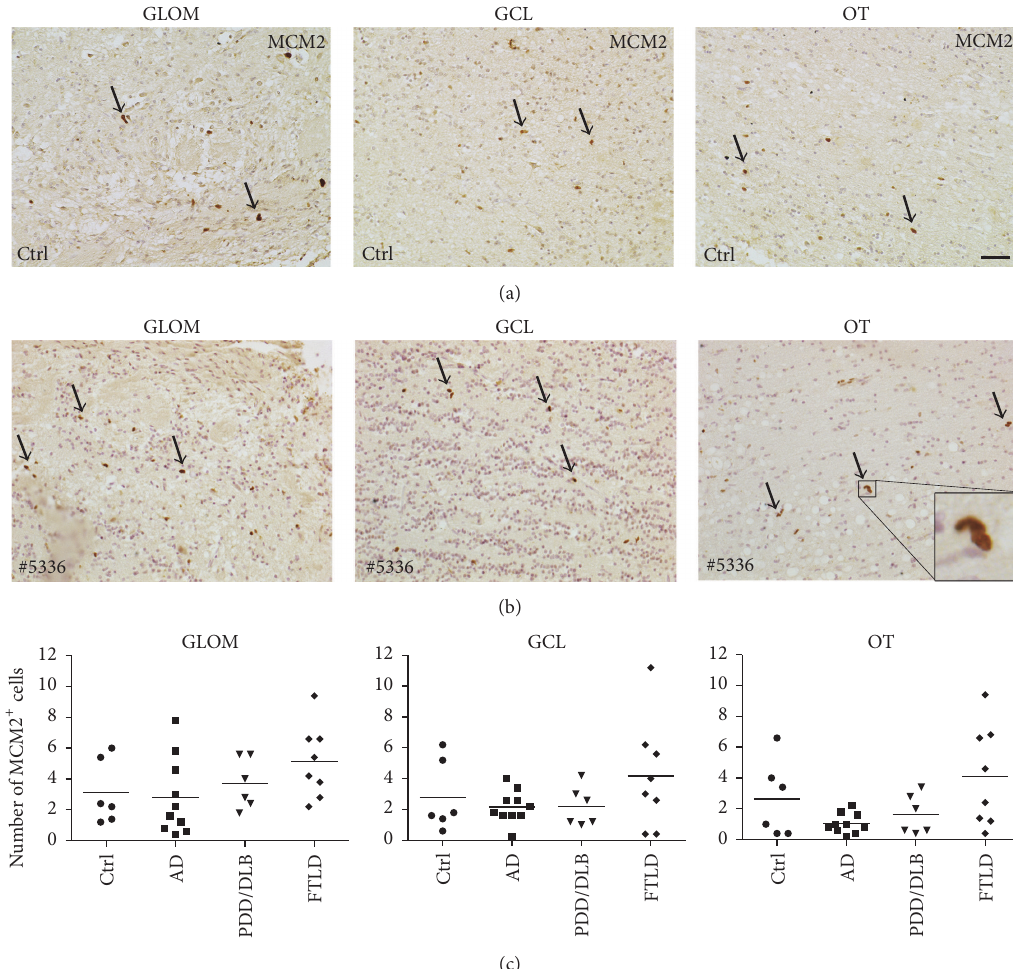
Figure 6: The number of proliferating cells in the GLOM, GCL, and OT of the OB was very low and not altered in AD, PDD/DLB, or FTLD compared to controls. Representative images depicting proliferating cells expressing the marker MCM2 in the GLOM, GCL, and OT in a control (a) and in FTLD ((b) case #5336), with higher magnification of typical doublet of MCM2+ cells (insert). The quantification of MCM2-positive cells revealed no significant difference between controls and AD, PDD/DLB, or FTLD for GLOM and GCL, as well as for the OT (c). 1-way ANOVA, 𝑝 > 0.05 for all groups. Scale bar represents 50 𝜇